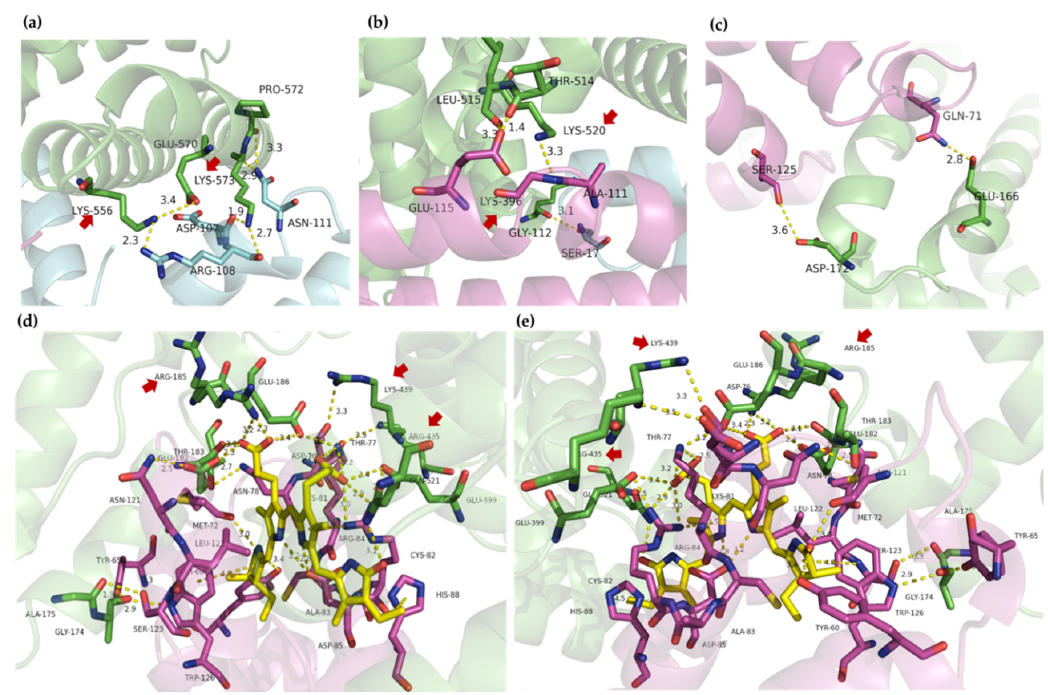
Figure 5. Secondary interaction of areas A ( a ), B ( b ), D ( c ) and C ( d , e ) in docking models. The green chain is BSA, whereas the pink and blue ones are α and β subunits of C-phycocyanin, respectively. Area C containing phycocyanobilin (yellow structure) is viewed from different angles ( d , e ). Red atoms are oxygen and blue atoms are nitrogen. Hydrogen bonds are shown in yellow dotted lines. Unit of length is Å.